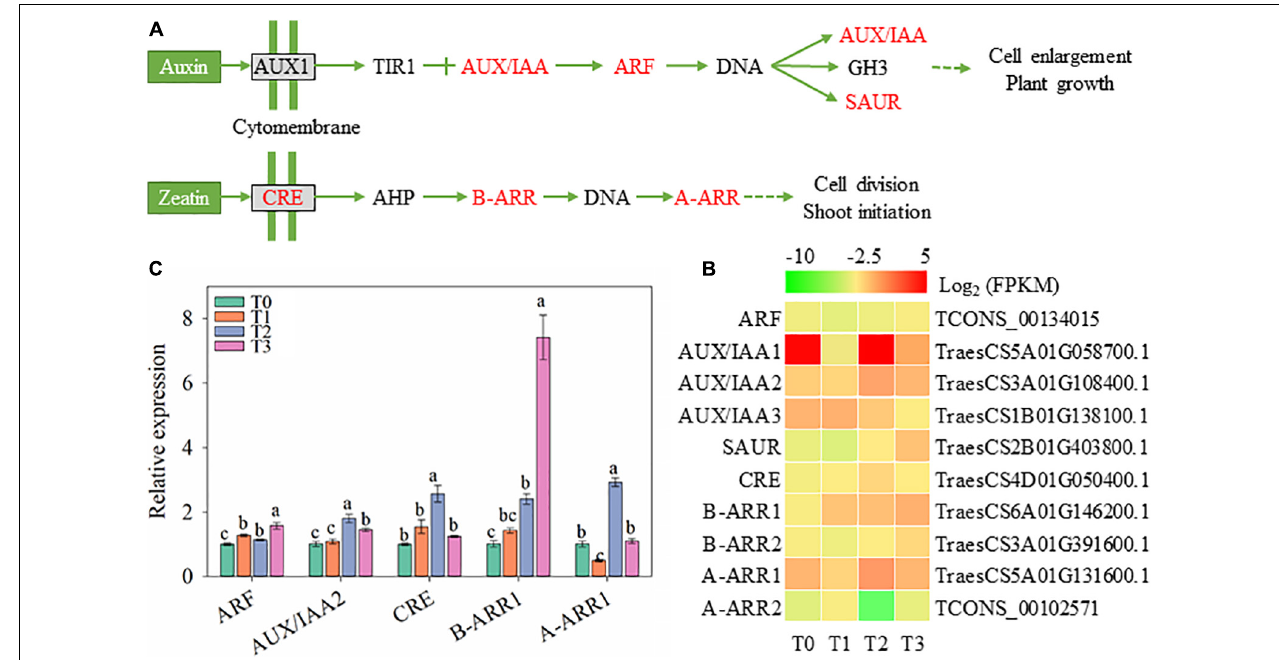
FIGURE 9 | Genes involved in the biosynthesis and signal transduction of IAA and cytokinins. ARF, auxin response factor; SAUR, small auxin-up RNA; CRE, cytokinin receptor; B-ARR, type-B Arabidopsis response regulator; A-ARR, type-A Arabidopsis response regulator. (A) Pathway map of the biosynthesis and signal transduction pathways of auxins, cytokinins, and ABA. (B) Heatmap of differentially expressed mRNAs in this pathway. (C) Verification of the expression of some genes in the pathway. Data are the mean values of four independent replicates ( n = 4), and error bars show the standard error. Duncan’s multiple-comparison test was used for ANOVA, and different lowercase letters indicate a significant difference at the level of P < 0.05). T0, T1, T2, and T3 means the sample was harvested at 0, 2, 24, and 72 h after mowing,